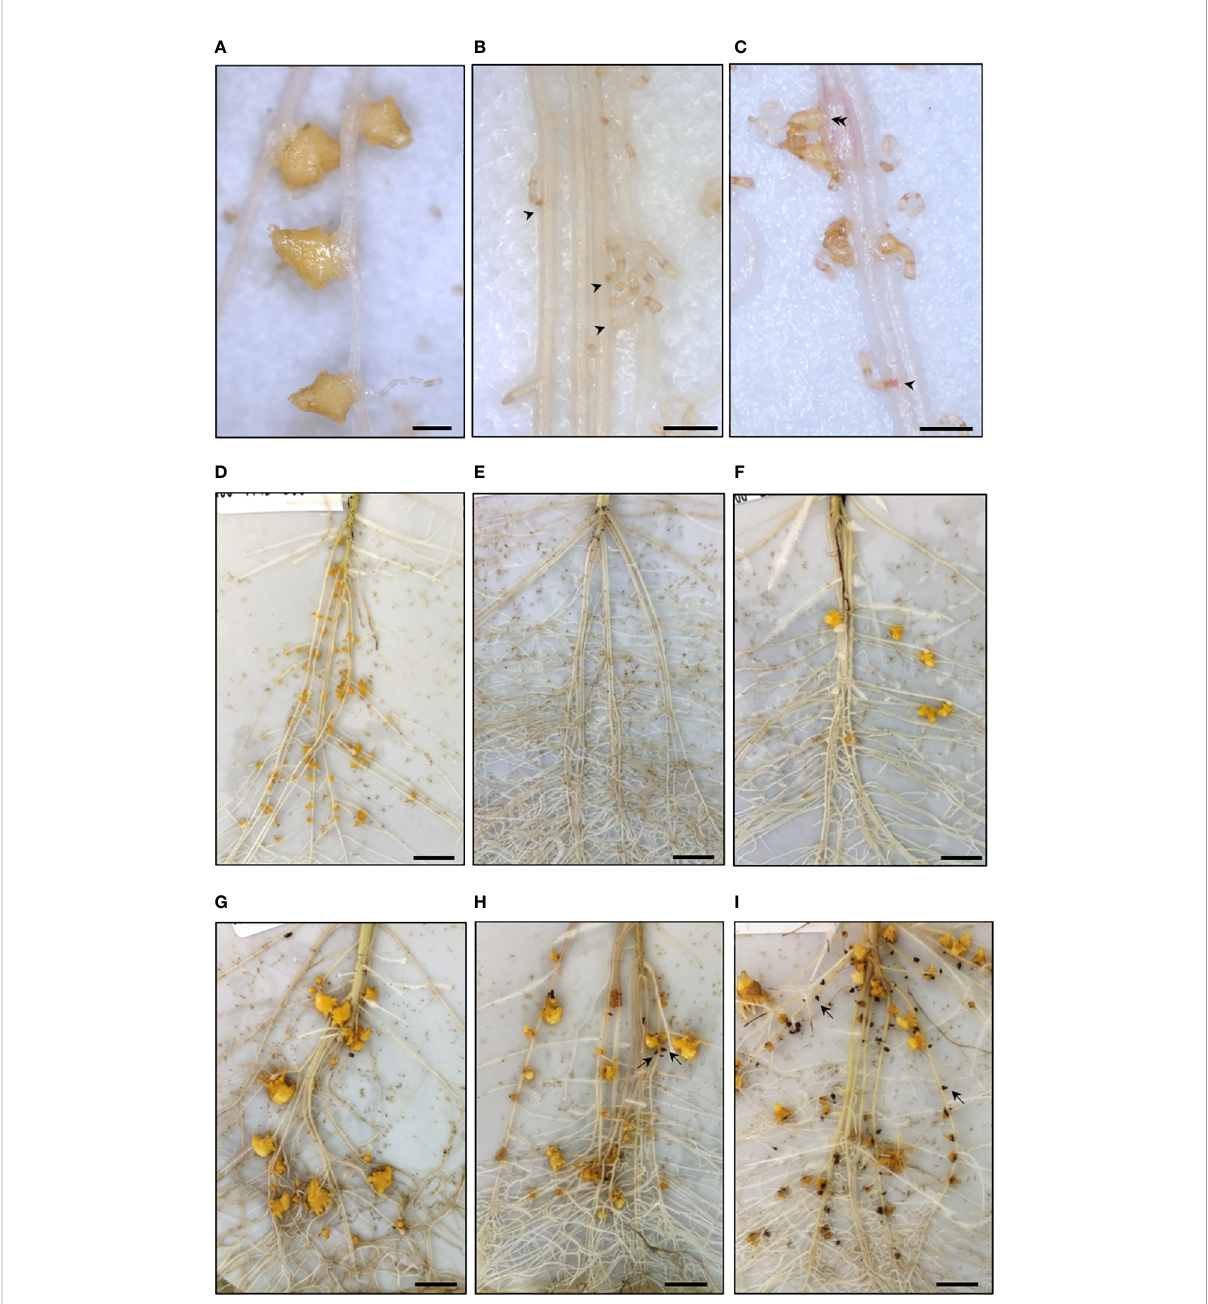
FIGURE 4 Early resistance stages of wild Helianthus species phenotyped in rhizotron using the broomrape race E-BOU. (A – C) Attachments at 14 dai. (A) Compatible attachments, accession #826 H . annuus (rhizotron non-treated). (B) Incompatible attachments, accession #783 H . divaricatus (arrow heads). (C) Mix of incompatible (arrowhead) and compatible attachments (double arrowhead), accession #761 H . petiolaris . (D – F) . Tubercles at 21 dai. (D) High number of tubercles, accession #774 H . annuus. (E) Absence of tubercles, accession #2601 H . exilis . (F) Low number of tubercles, accession #736 H . petiolaris . (G – I) Necrotic tubercles at 28 dai (examples indicated by arrows). (G) Absence of necrotic tubercles, accession #774 H . annuus (rhizotron non-treated). (H) Low percentage of necrotic tubercles, accession #677 H . praecox . (I) High percentage of necrotic tubercles, accession #786 H . debilis . A – C. Bar = 1 mm. D – I. Bar = 1 cm. All pictures were taken from rhizotrons treated with GR24+ DCL, except for Figures 4A and G taken from non-treated